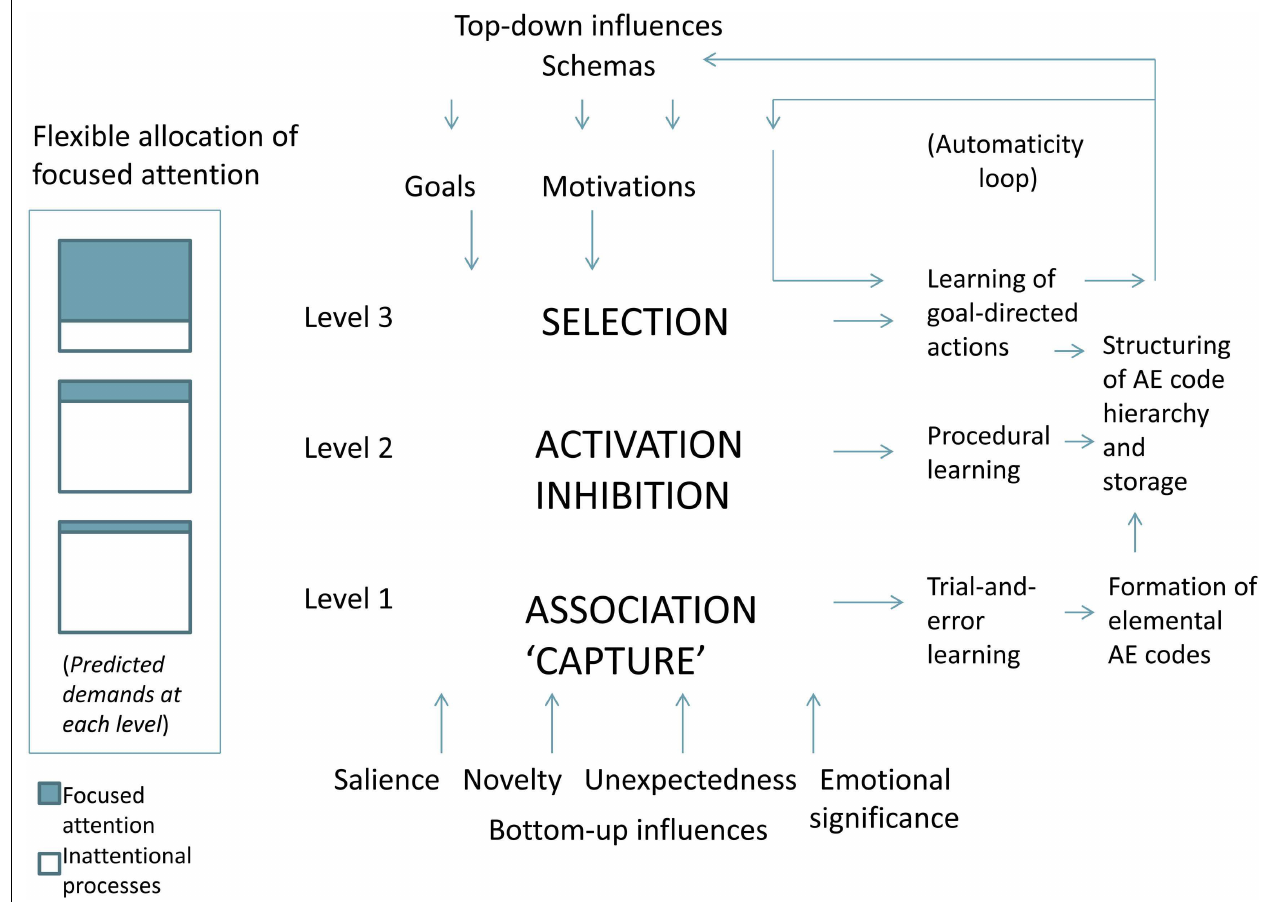
herein. An automaticity loop is shown in the upper right corner as an adaptive module built primarily upon level 3 of the system. In the far left panel is a depiction of the approximate proportion of focused attention versus inattentional processes predicted to be involved at each conceptualized level. AE, action-effects. See text for